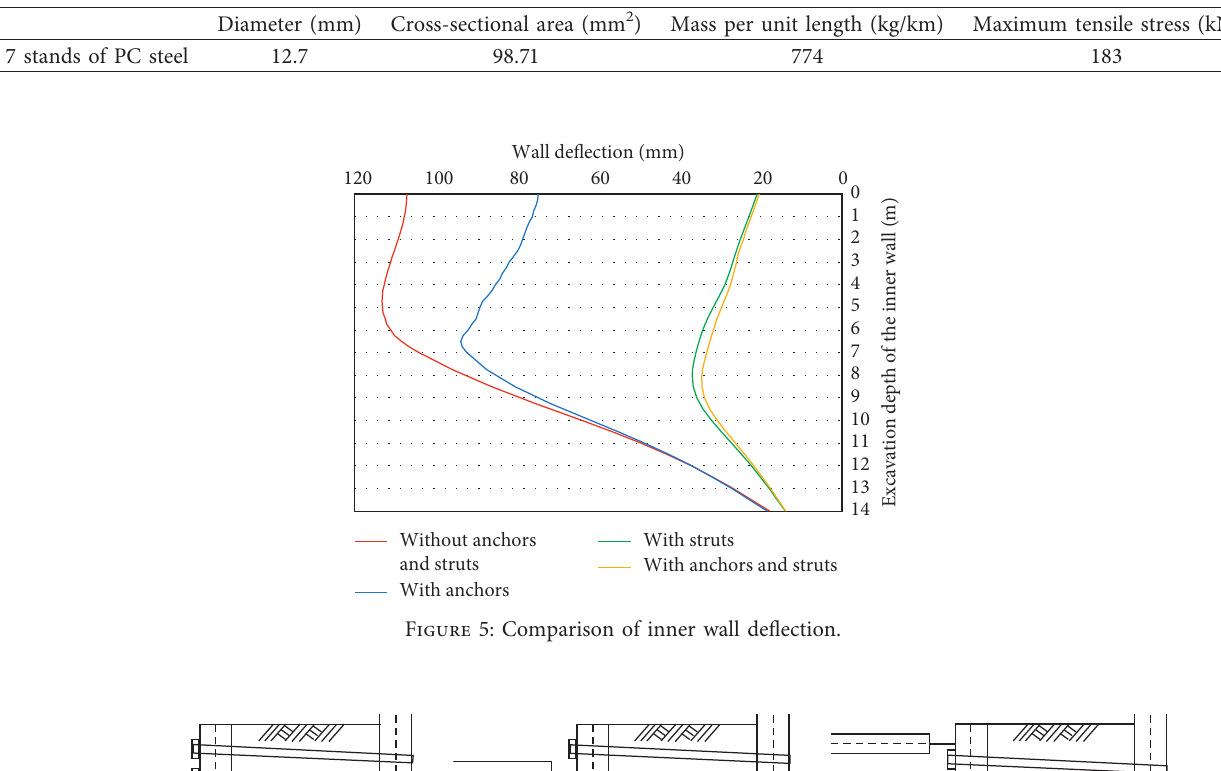
Table 4: Physical and mechanical properties of anchors.